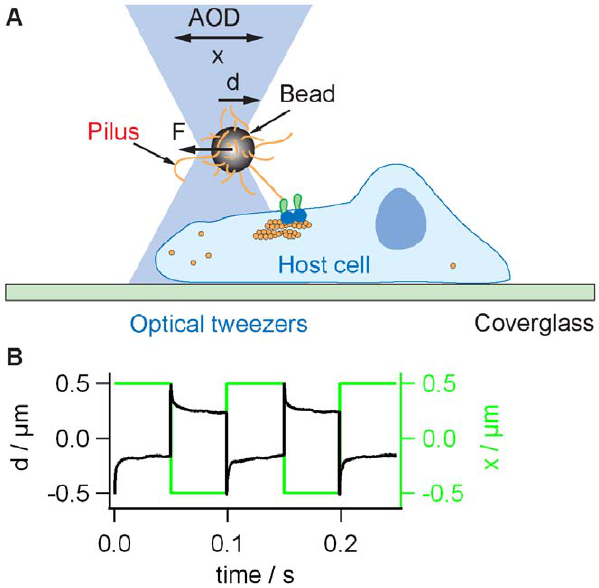
Figure 1. Experimental setup for ‘‘infection’’ with T4P-coated beads. A) Sketch of the setup. Beads were trapped and placed onto the surface of Hec1B cells. When the center of the laser trap is actively moved by x , the deflection of the bead from the center of the trap d is proportional to the force F . B) Green line: The laser focus was moved by x = 6 0.5 m m with respect to the initial position with a frequency of 10 Hz. Black line: Typical signal of the quadrant photodiode showing the position d . Deflection from 0 verifies binding of the bead to the surfaces of the epithelial cell .